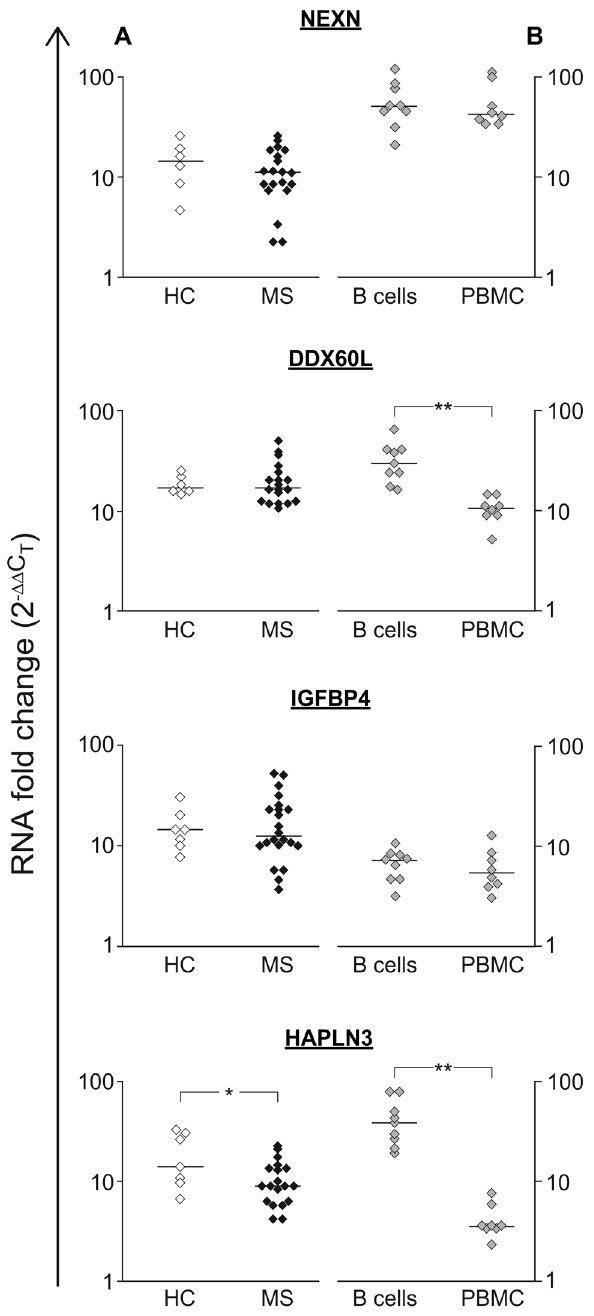
Figure 4. Validation of the gene expression response for four novel IFN- b response genes by real time RT-PCR. The change in expression levels (2- DD C T ) following four hours of IFN- b exposure is shown for four genes that are novel IFN- b response genes. The horizontal bars represent the median values. A: Comparison of the IFN- b response in LCLs from healthy controls (HC, empty symbols, n=7) and patients with multiple sclerosis (MS, full symbols, n=20). Fold changes for IFN- b response were significant for both groups (P-value , 0.007, Wilcoxon signed rank test). No difference was observed in the IFN- b response between controls and MS LCLs, except for HAPLN3 , for which the difference was of a small magnitude (*P-value , 0.05, Mann Whitney test). B: The IFN- b response in primary B cells (n=9) and PBMC (n=8) from healthy controls and MS patients. All genes displayed a significant response to IFN- b for both B cells and PBMC (P-value , 0.001, Wilcoxon signed rank test). Significant differences between the response in B